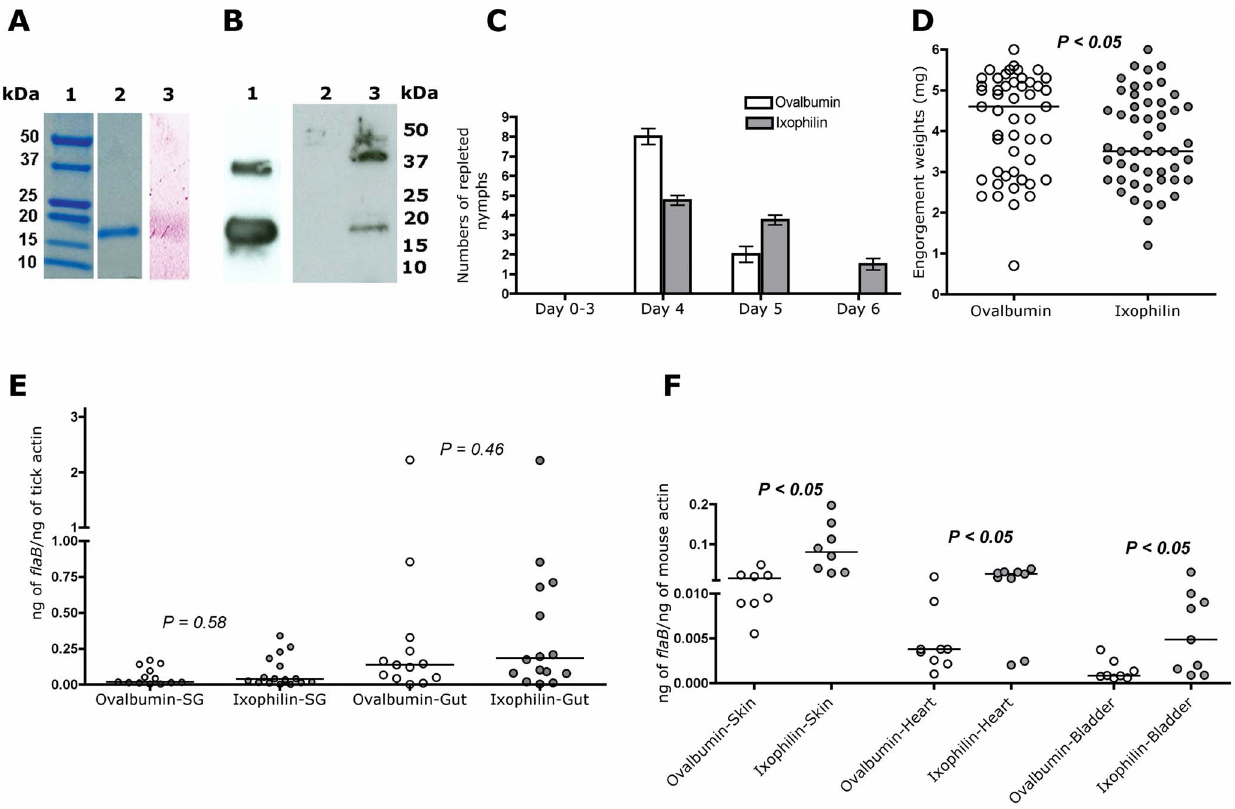
Figure 4. Immunization with rIxophilin delays time to repletion and enhances Borreliaburgdorferi burden in the murine host. A. Electrophoresis of rIxophilin on a 4–20% SDS PAGE. Lane 1, Precision Plus protein standards (BioRad); Lane 2, Coomassie Blue stain of rIxophilin; Lane 3, Glycoprotein stain of rIxophilin. B. Western blot probed with serum from a mouse immunized with rIxophilin. The proteins analyzed were: rIxophilin (lane 1); salivary gland extract prepared from 10 fed nymphs (lane 2); and gut extract prepared from 5 fed nymphs. C. 10–12 pathogen-free nymphs were fed on each of five ovalbumin or rIxophilin-immunized mice, and time to repletion in each group recorded. Error bars represent mean 6 SEM. D. Engorgement weights of nymphs fed on ovalbumin or rIxophilin-immunized mice. Each data point indicates one nymph. E. Quantitative PCR assessment of flaB levels as a measure of B. burgdorferi burden in guts (Gut) and salivary glands (SG) of nymphs fed to repletion on each ovalbumin or rIxophilin-immunized mice. Each data point represents a pool of 2 guts or salivary glands. F. Quantitative PCR assessment of flaB levels as a measure of B. burgdorferi burden in skin, bladder and heart tissues of ovalbumin or rIxophilin-immunized mice 21 days post-tick detachment. Each data point represents tissue from one mouse. E and F represent a composite of 2 replicate experiments. Horizontal bars represent the median, and mean values significantly different in a two-tailed non-parametric t-test (P , 0.05) indicated.